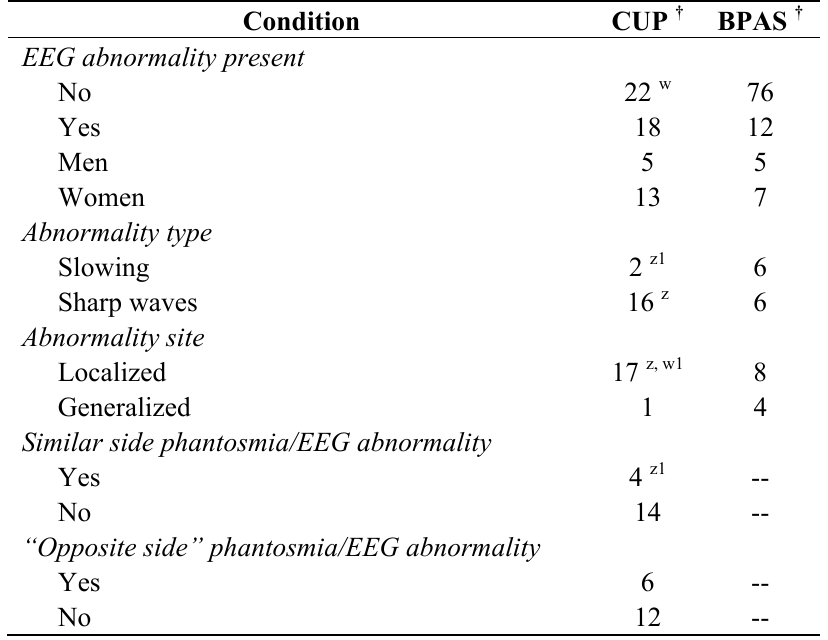
Table 7. EEG characteristics in patients with phantosmia.